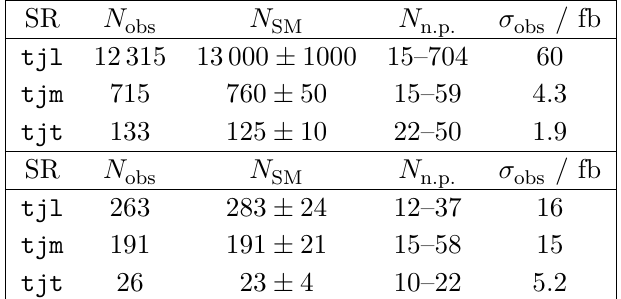
Table 2 . Lower limits (at 95 % CL) on the visible cross section for three signal regions (SR) in the Run 1 ATLAS dijet plus missing E